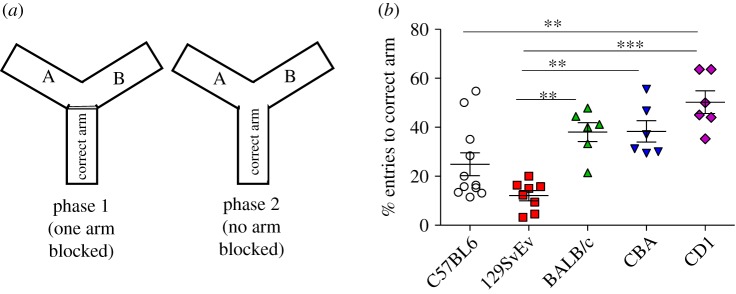
Y-maze task with one arm blocked. (a) Representation phases of task. (b) Per cent entries into the correct arm as a measure of spatial learning and memory. Data shown are calculated at level of significance with *p ≤ 0.05, **p ≤ 0.01 and ***p ≤ 0.001.